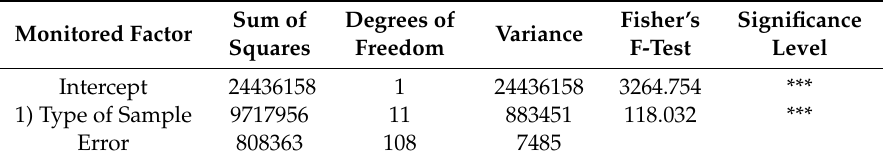
Table 11. Statistical evaluation of the e ff ect of the factors and their interaction on the minimum bend radius at the yield point ( R minC ) for aspen and NWC on the bottom.